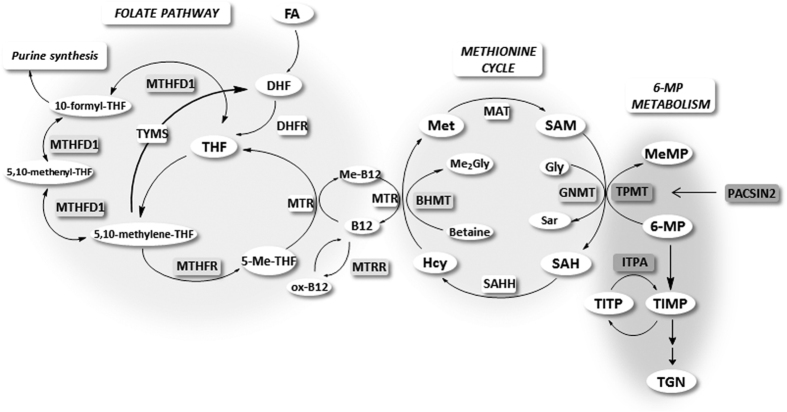
Scheme of the folate pathway, the methionine cycle and 6-MP metabolism.6-MP, 6-mercaptopurine; BHMT, betaine-homocysteine S-methyltransferase; DHF, dihydrofolate; DHFR, dihydrofolate reductase; FA, folic acid; Gly, glycine; GNMT, glycine N-methyltransferase; Hcy, homocysteine; ITPA, inosine triphosphate pyrophosphatase; MAT, methionine adenosyltransferase; ox-B12, oxidised form of vitamin B12; Me2Gly, dimethyl-glycine; MeMP, methylmercaptopurine; Met, L-methionine; 5-Me-THF, 5-methyltetrahydrofolate; 5,10-methylene-THF, 5,10-methylenetetrahydrofolate; 5,10-methenyl-THF, 5,10-methenyltetrahydrofolate; MTHFD1, methylenetetrahydrofolate dehydrogenase (NADP + Dependent) 1; MTHFR, 5,10-methylenetetrahydrofolate reductase; MTR, 5-methyltetrahydrofolate-homocysteine methyltransferase; SAH, S-adenosyl-L-homocysteine; SAHH, S-adenosyl-L-homocysteine hydrolase; MTRR, 5-methyltetrahydrofolate-homocysteine methyltransferase reductase; SAM, S-adenosyl-L-methionine; Sar, sarcosine; THF, tetrahydrofolate; TGN, thioguanosine; TIMP, thioinosine monophosphate; TITP, thioinosine triphosphate, TPMT, thiopurine S-methyltransferase; TYMS, thymidylate synthetase.